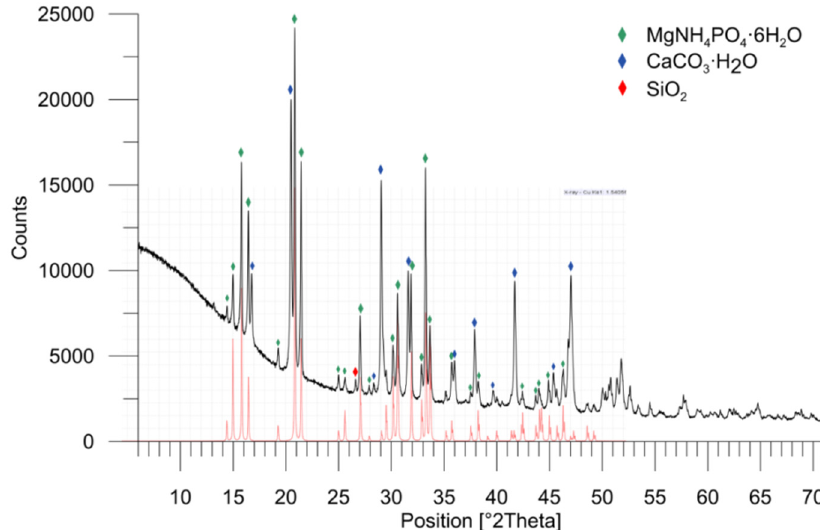
Figure 3. X-ray diffraction pattern of the product from the bio-refinery with struvite (STR) evidence: struvite (MgNH 4 PO 4 · 6H 2 O)-green, monohydroxycalcite (CaCO 3 · H 2 O)-blue, and quartz (SiO 2 )-red;